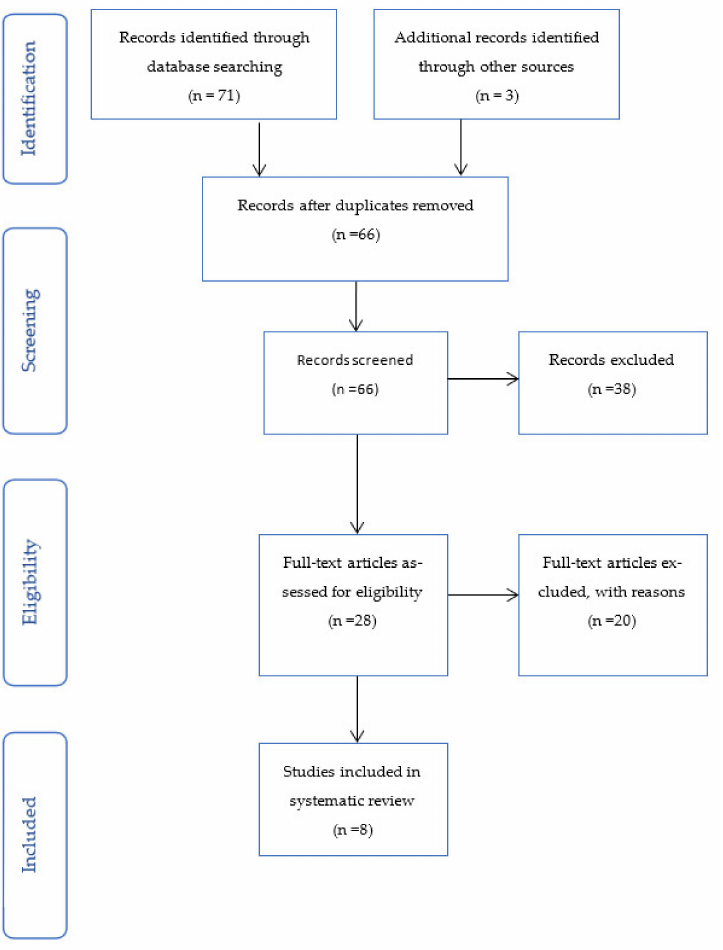
Figure 2. A PRISMA diagram demonstrating the study selection process for study question 1. This flowchart outlines the search and selection process employed in study question 1—Is sperm HAB score prior to insemination predictive of clinical